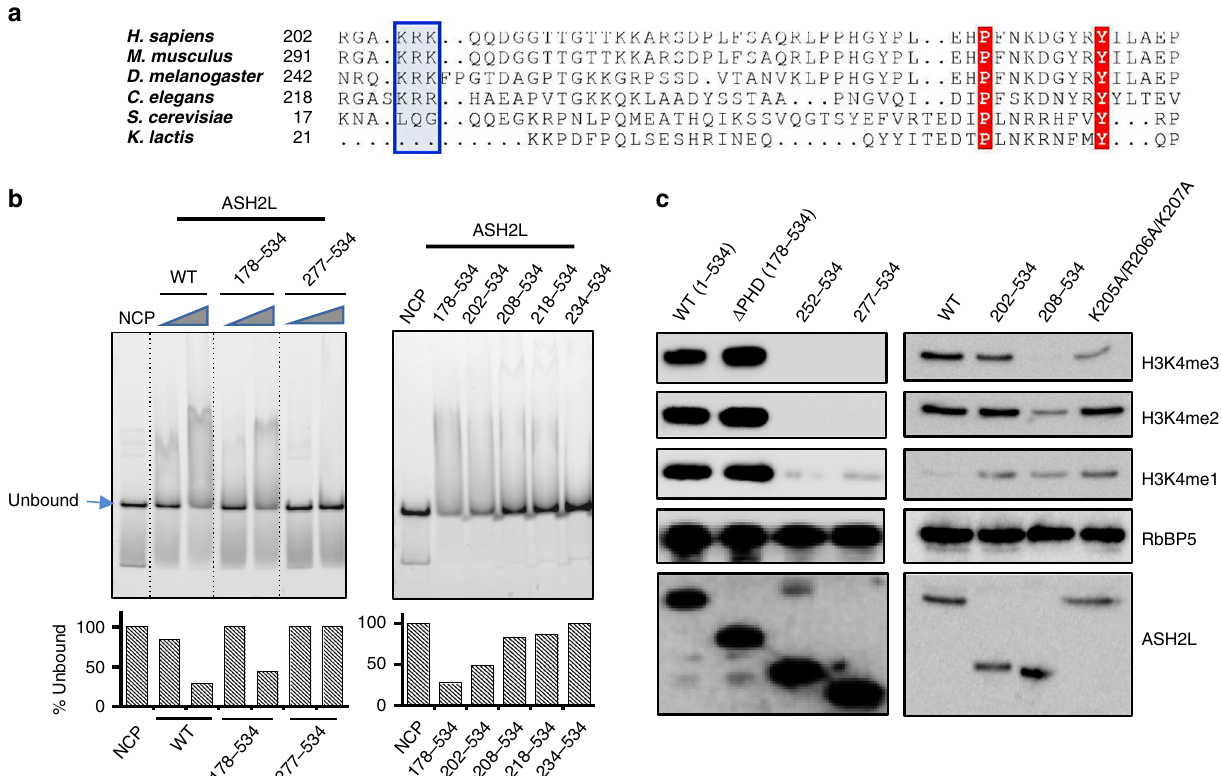
Fig. 5 ASH2L Linker-IDR is important for NCP binding and methyltransferase activity. a Multiple sequence alignment of ASH2L Linker-IDR region (residues 202 – 254). The blue box indicated 205 -KRK- 207 , key residues for NCP recognition. b Top, electrophoretic mobility shift assay of ASH2L and ASH2L mutants as indicated on top. Bottom, the unbound NCP in the gel image was quanti fi ed by ImageJ and presented after normalization against the NCP alone signal, which was arbitrarily set as 1 (100%). This experiment was repeated separately to con fi rm the main conclusions. c Immunoblot to detect in vitro histone methyltransferase activity with the NCP as the substrate. Reconstituted MLL1 RWSAD complexes containing wild-type and mutant ASH2L, used as indicated on top. Immunoblots of RbBP5 and ASH2L included as